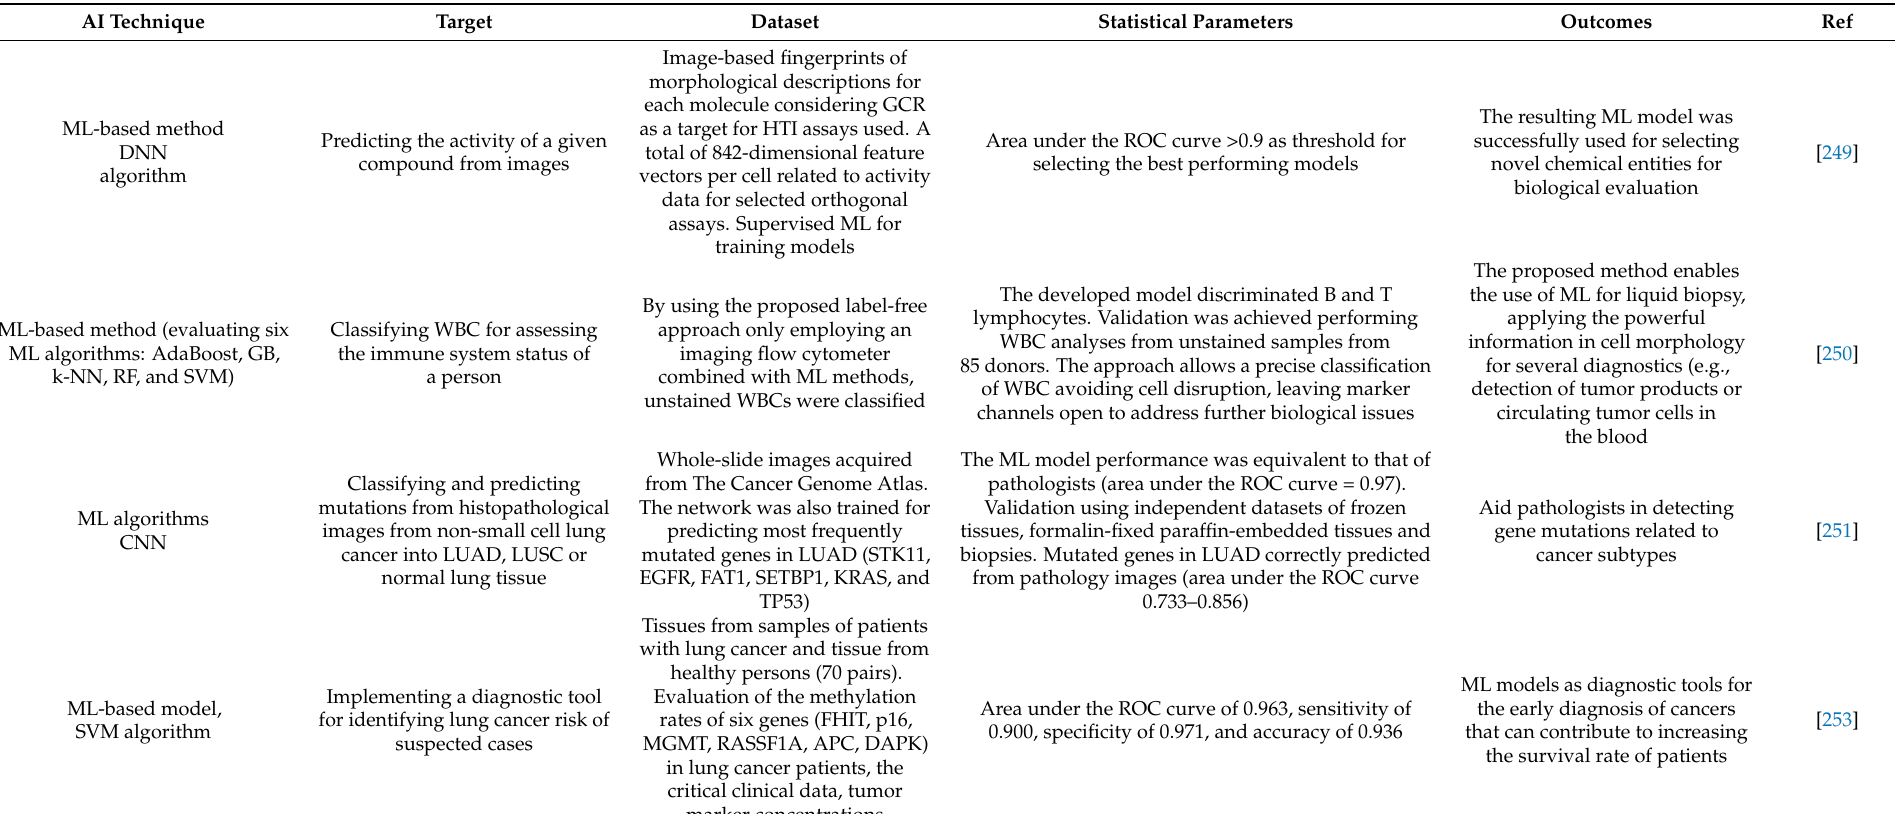
Table 4. Main examples of AI/ML in basic